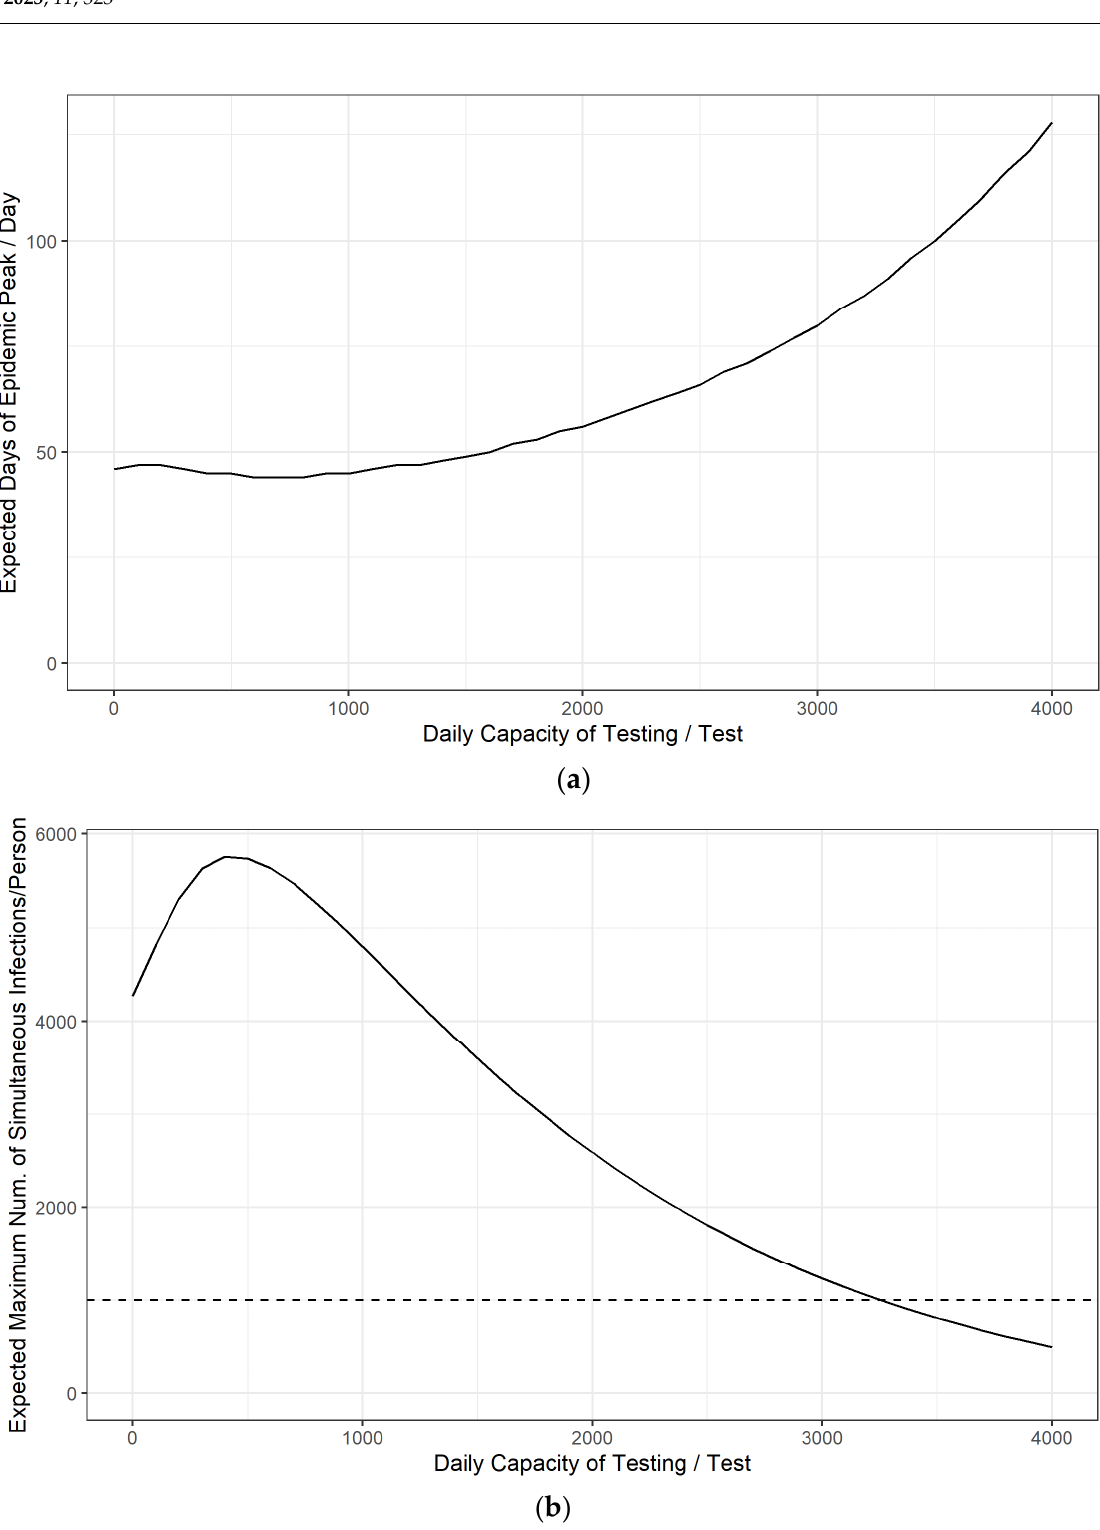
Figure 2. Effect of daily testing capacity on the timing and scale of the arrival of the epidemic peak. ( a ) Time of onset of the top of the outbreak; ( b ) Number of the infected at the onset of the peak of the epidemic.